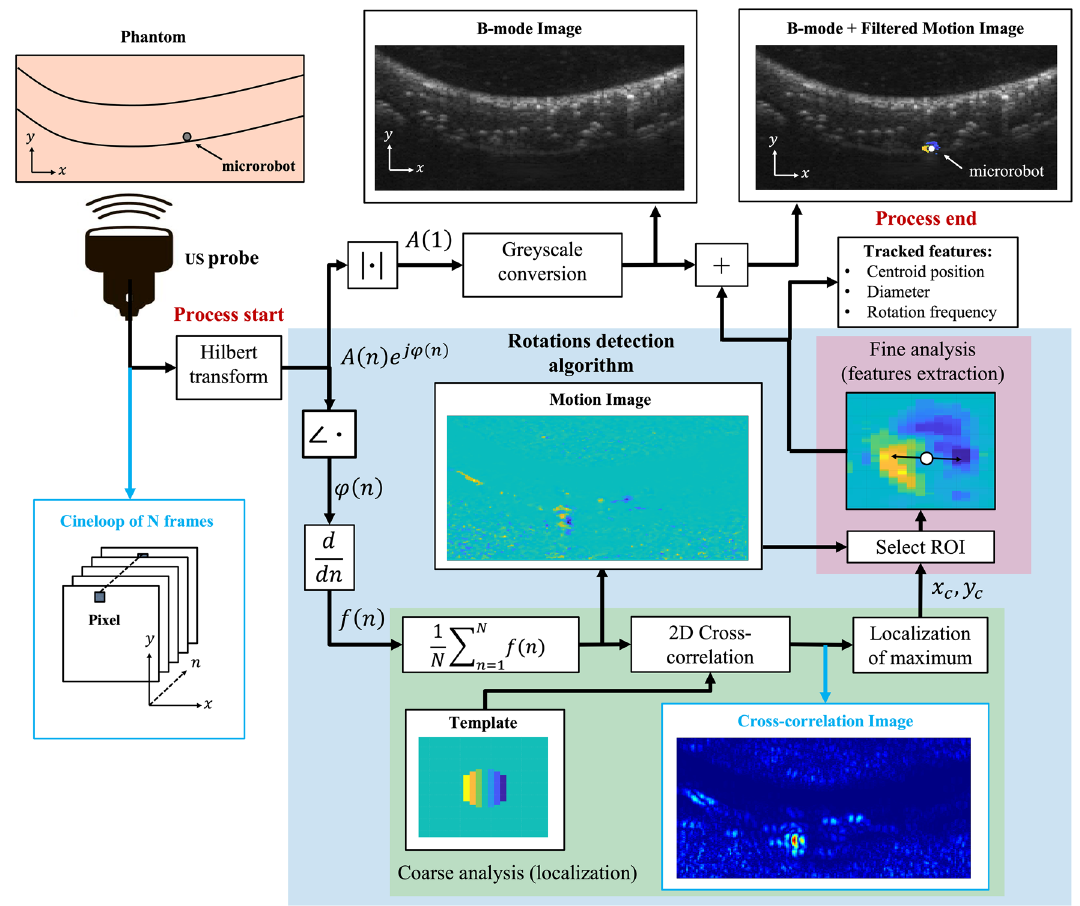
Figure 2. Acoustic phase processing for enhanced contrast US imaging and tracking of a rotating microrobot. Algorithm flow chart: Ultrasound RF data are acquired in the form of a cineloop from the probe. For each pixel in the cineloop, the analytic acoustic signal in the time dimension (n) is obtained through the Hilbert transform from the raw RF data. The instantaneous amplitude A is used for B-mode imaging, while the instantaneous phase ϕ is analyzed for tracking the rotating MR (light blue box). Fast MR localization is achieved through a coarse phase analysis over the whole image plane (green box). Then a fine analysis is performed in a ROI defined around the centroid and features as MR diameter and rotating frequency are estimated by analyzing the velocity distribution (pink box). Finally, the selected ROI (Filtered Motion Image) is overlapped on a B-mode image for enhanced imaging and tracking. Illustrative outcomes of the process along the pipeline are displayed by the bright blue arrows in the flow